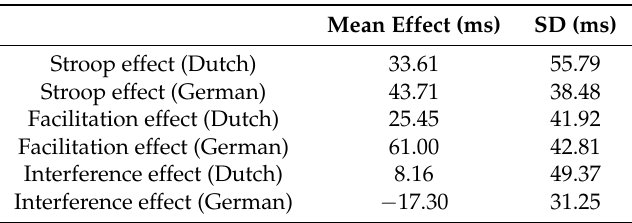
Table 5. Stroop effects of the multilingual group L1 Dutch without knowledge of German in the Dutch Stroop task and in the German Stroop task.